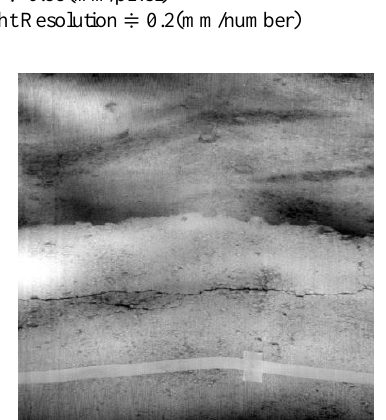
Figure 2. 3D laser scan image data